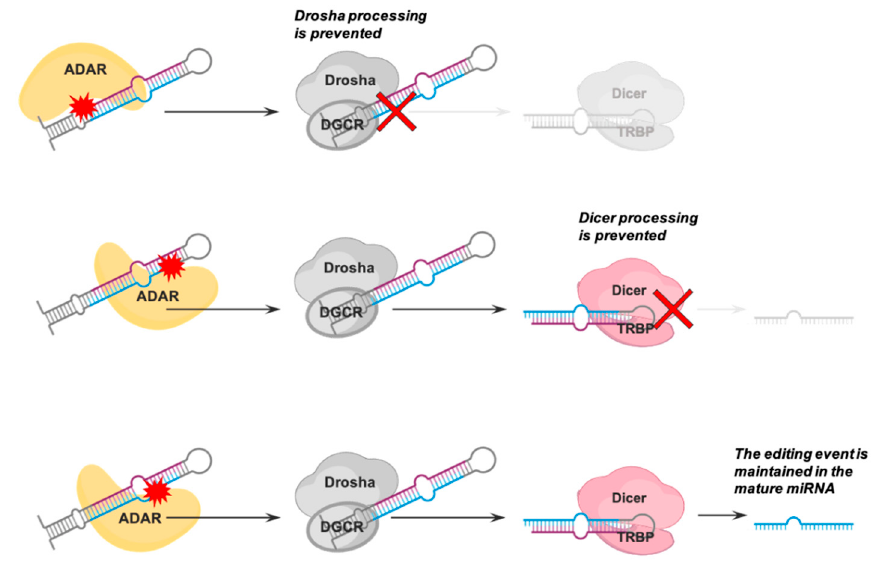
Figure 2. Steps of miRNA biogenesis at which adenosine to inosine (A-to-I) RNA editing can prevent the processing of pri- or pre-miRNA. In certain cases, however, the A-to-I editing event does not impair miRNA biogenesis and is maintained in the mature miRNA.